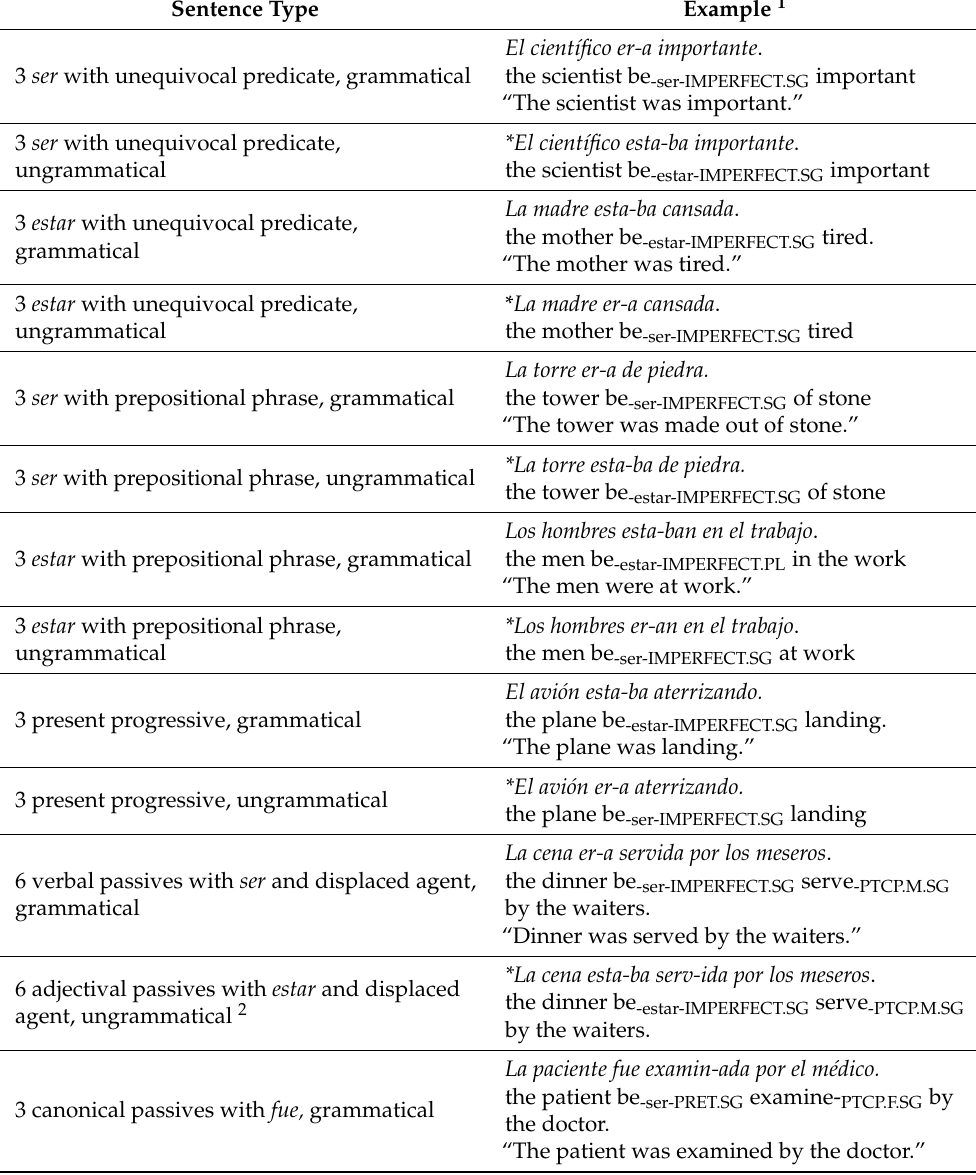
Table 3. Grammaticality judgment task (GJT) sentences with